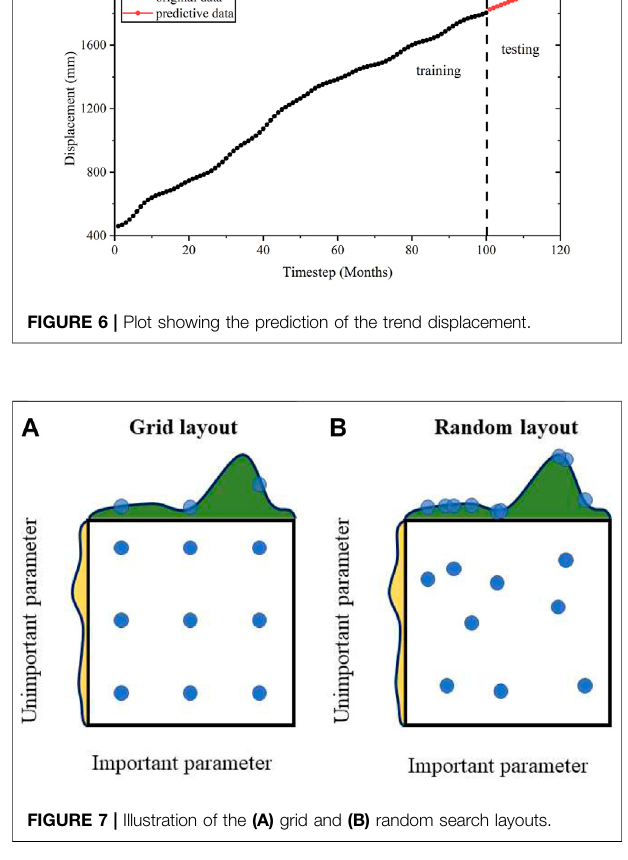
TABLE 3 | Data for parameters of the GS-SVR model used for periodic displacement prediction.